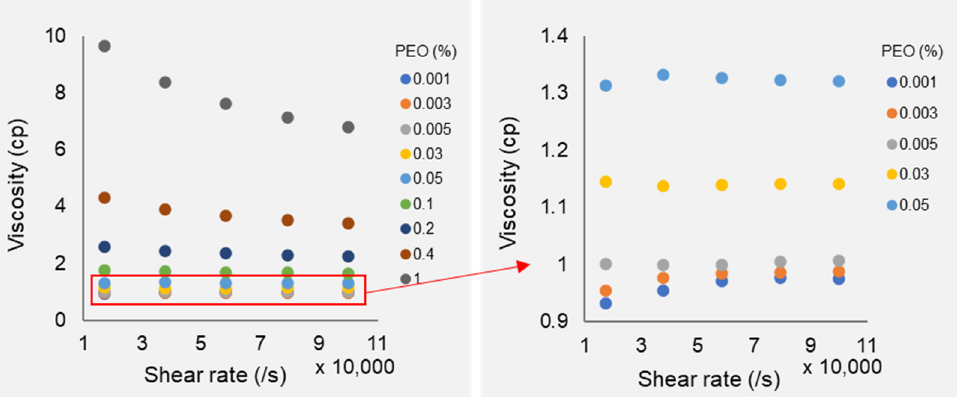
Figure 3. PEO solution viscosity under high shear rates. High concentration PEO solutions are shear ‐ thinning with an increase of flow rate. Low concentration PEO solutions (details are shown on the right figure) exhibit constant shear rate.